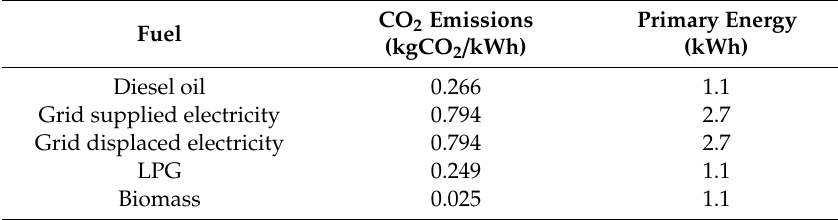
Table A1. Conversion factors for di ff erent types of fuels to primary energy units